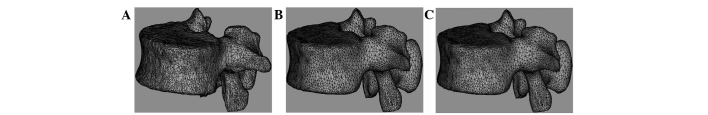
Split-based method of imaging the vertebral body. (A) Raw model prior to polishing, (B) smoothed model after polishing and (C) model after remeshing.